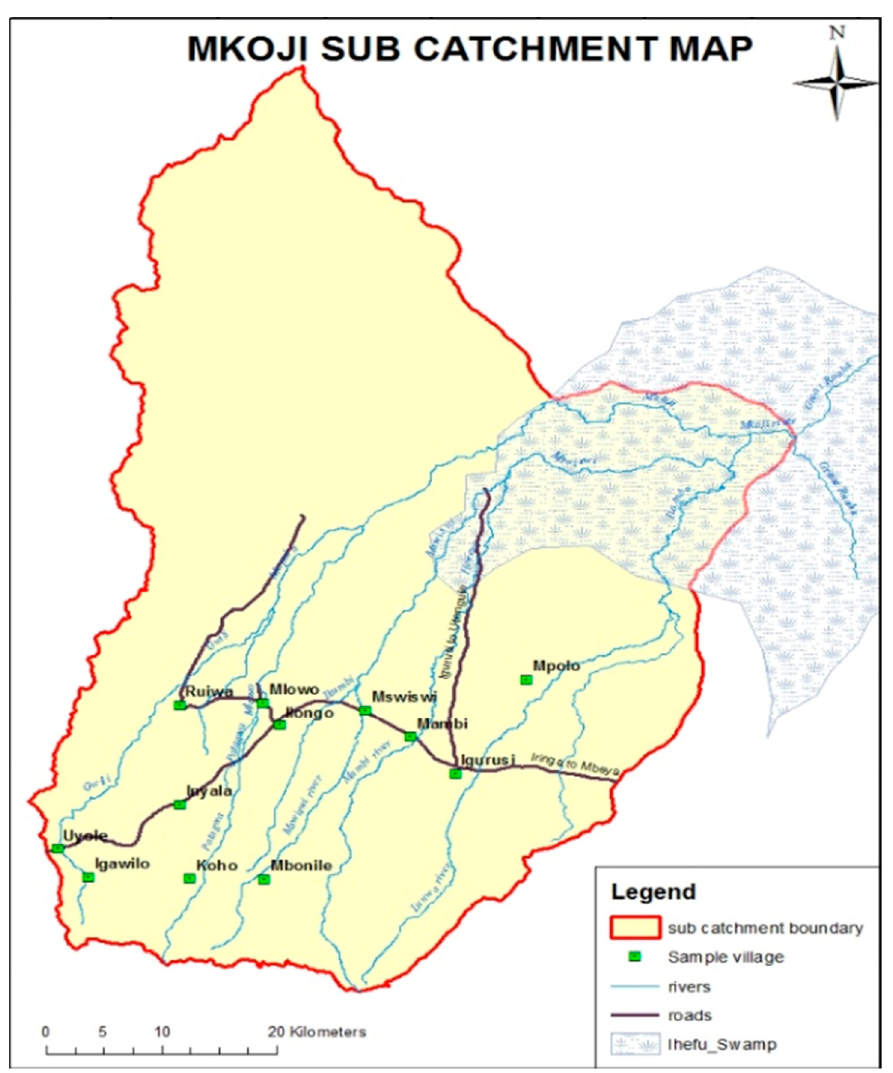
Figure 2. The Mkoji sub-catchment.